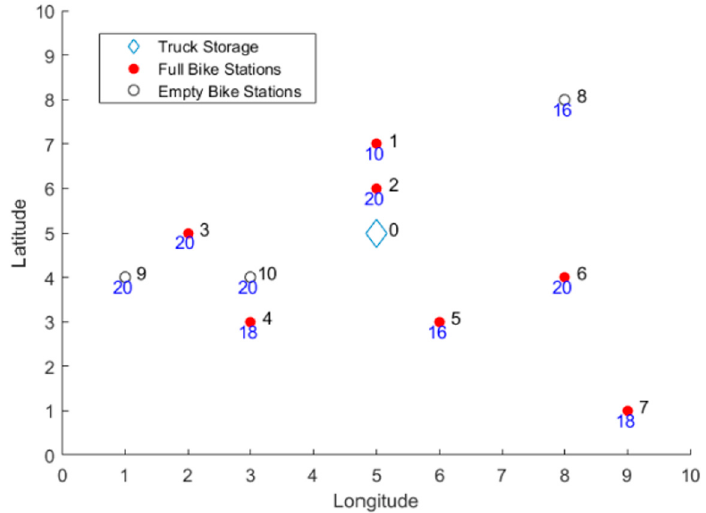
Figure 8. Geographical representation of a hypothetical subregion of a bike-sharing system.